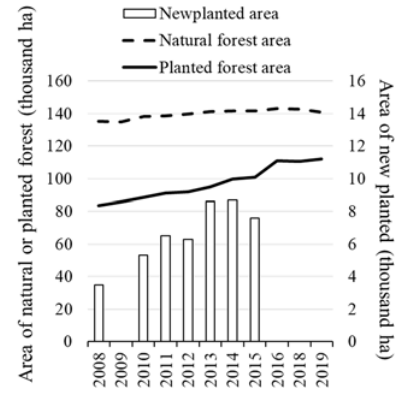
Figure 4. Transition of natural and planted forest area in Quang Tri Province. Note: The statistics on the area of new tree plantations established from 2016 to 2019 are missing. Source: [19].